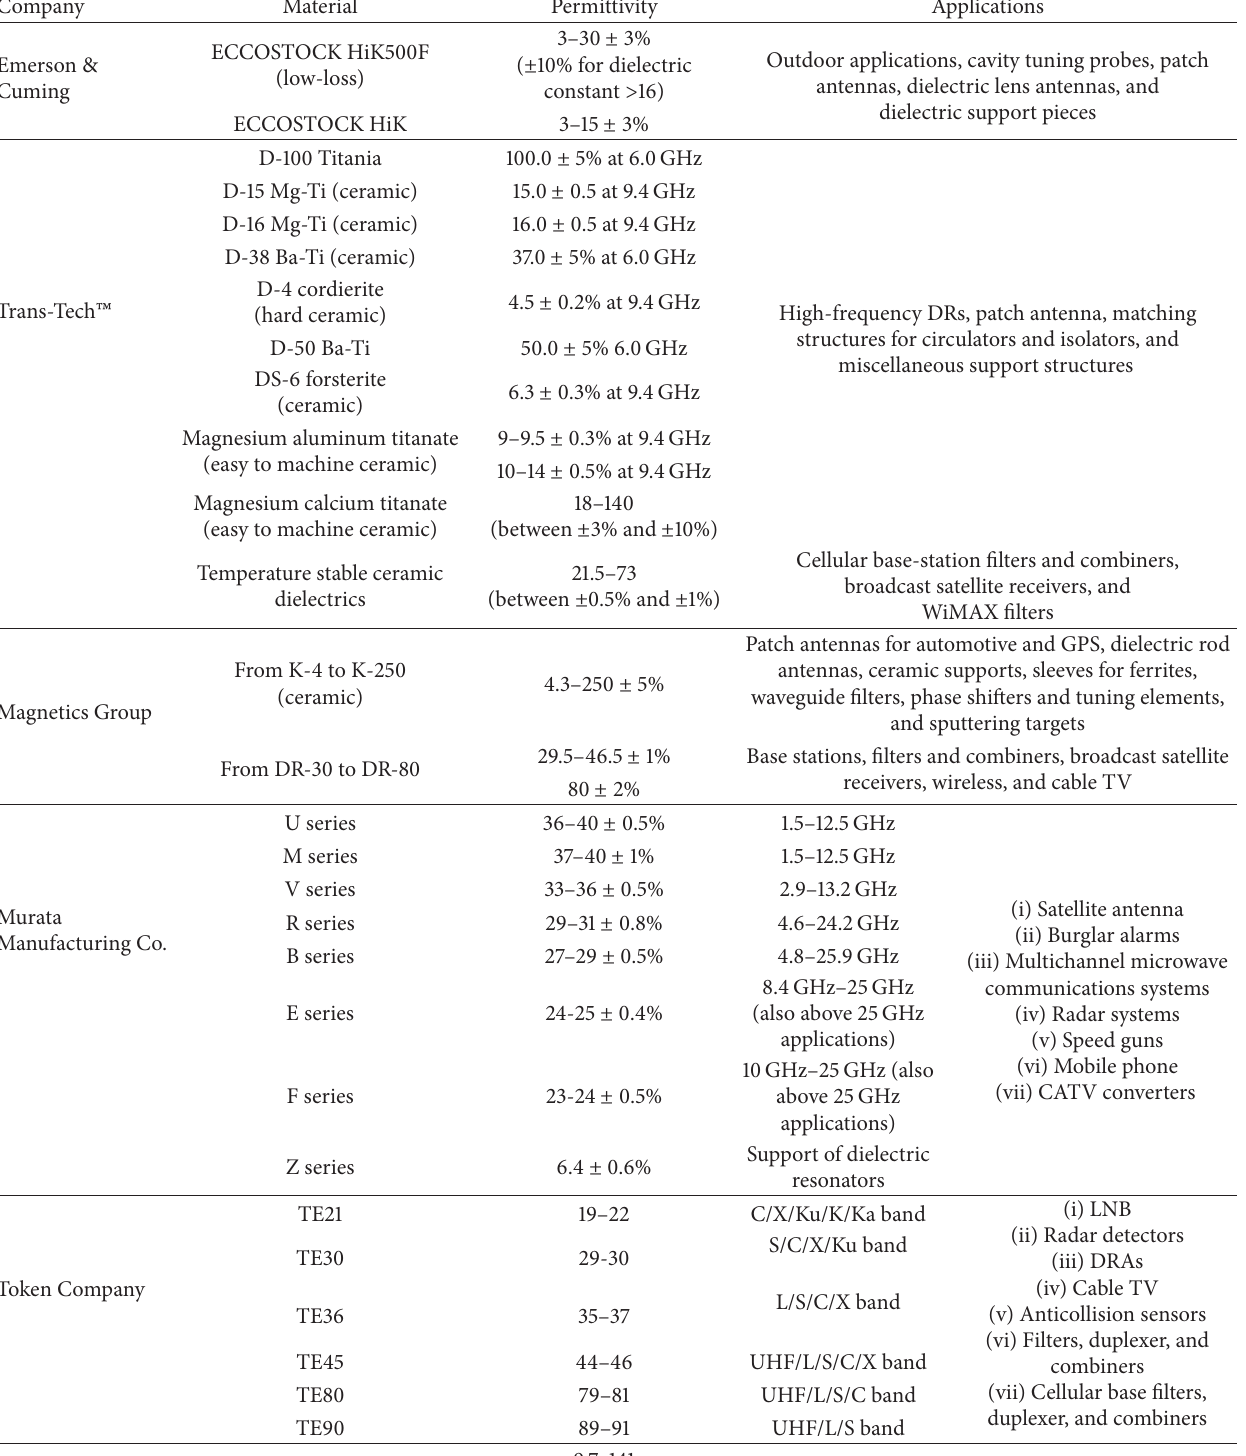
Table 6: Dielectric materials for DRAs